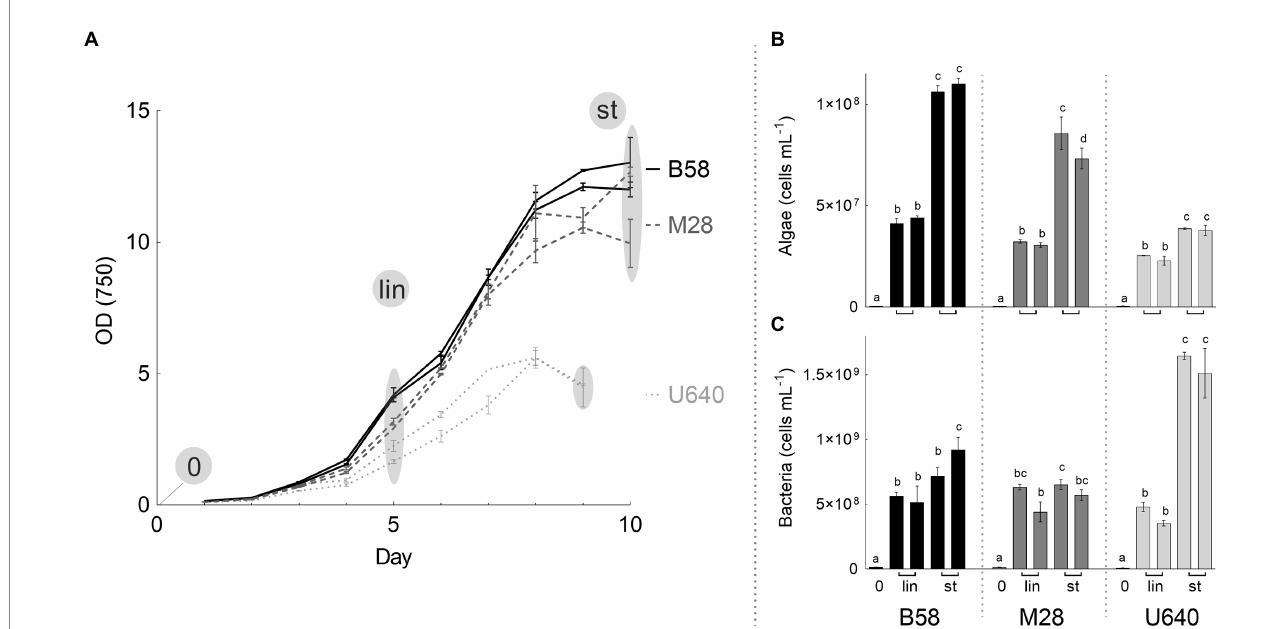
FIGURE 6 Batch cultivation of three Phaeodactylum strains in bubble columns with two biological replicates each. (A) OD-based growth curves with the three sampling time points (gray circles) for cell concentration and microbiome analysis, 0 = start of the cultivation, lin: linear growth phase, st: stationary phase. (B) Microalgal and (C) Bacterial cell concentration at the respective sampling time points. On day 0 samples were taken from the starting culture before being divided in two cultures resulting in one sample for this sampling time point. Values show average and standard deviation of two (OD) or three (cell counts) measurement replicates. For each strain, means of algal or bacterial cell concentrations with the same letter are not significantly different ( p > 0.05).